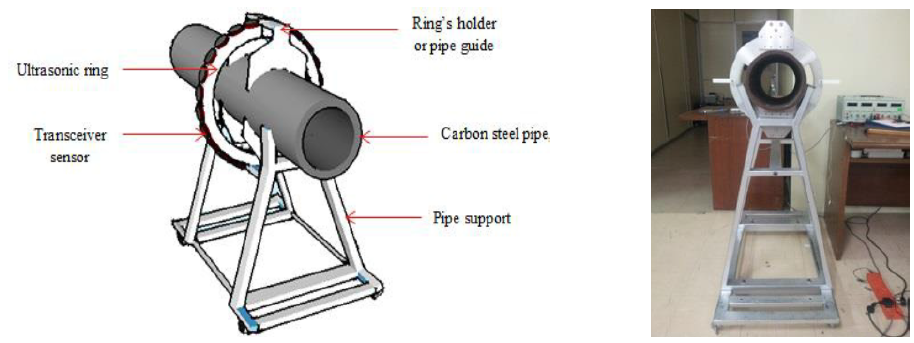
Figure 42. The setup for the ultrasonic tomographic instrumentation system. Reprinted under Creative Commons CC BY-NC-ND license